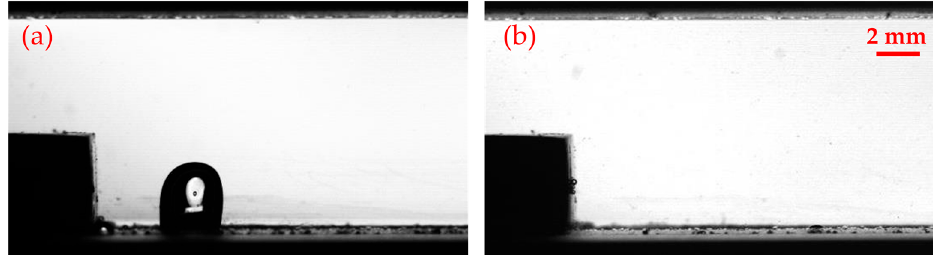
Figure 9. Comparison of laminar flow and turbulent flow. ( a ) Re > 2300; ( b ) Re < 2300.